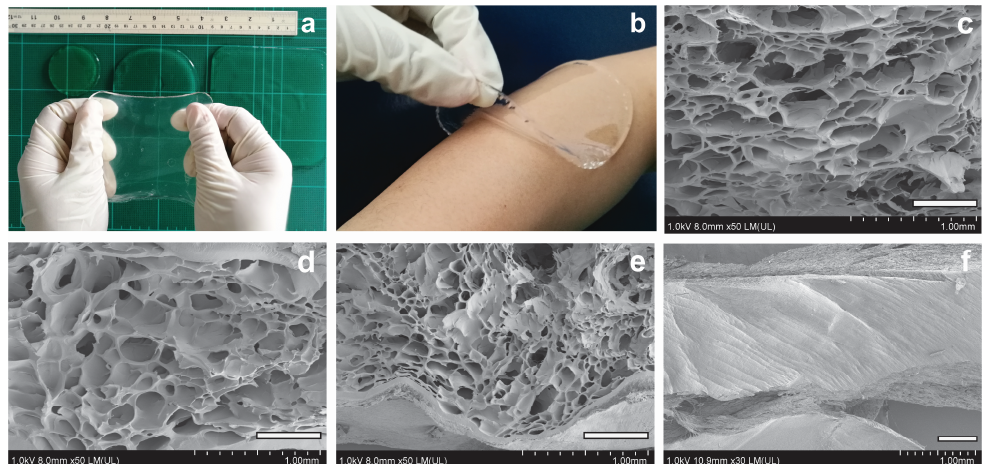
Figure 3. Morphology of the crosslinked PVA hydrogel sheets. Representative digital images of ( a ) stretchable and ( b ) conformal hydrogel sheets fabricated by irradiation at 40 kGy. SEM images showing a porous microstructure inside the hydrogel matrices crosslinked at doses of ( c ) 25, ( d ) 40, and ( e ) 60 kGy compared to the ( f ) as-cast hydrogel sheet. Scale bars are 500 mm in ( c – f